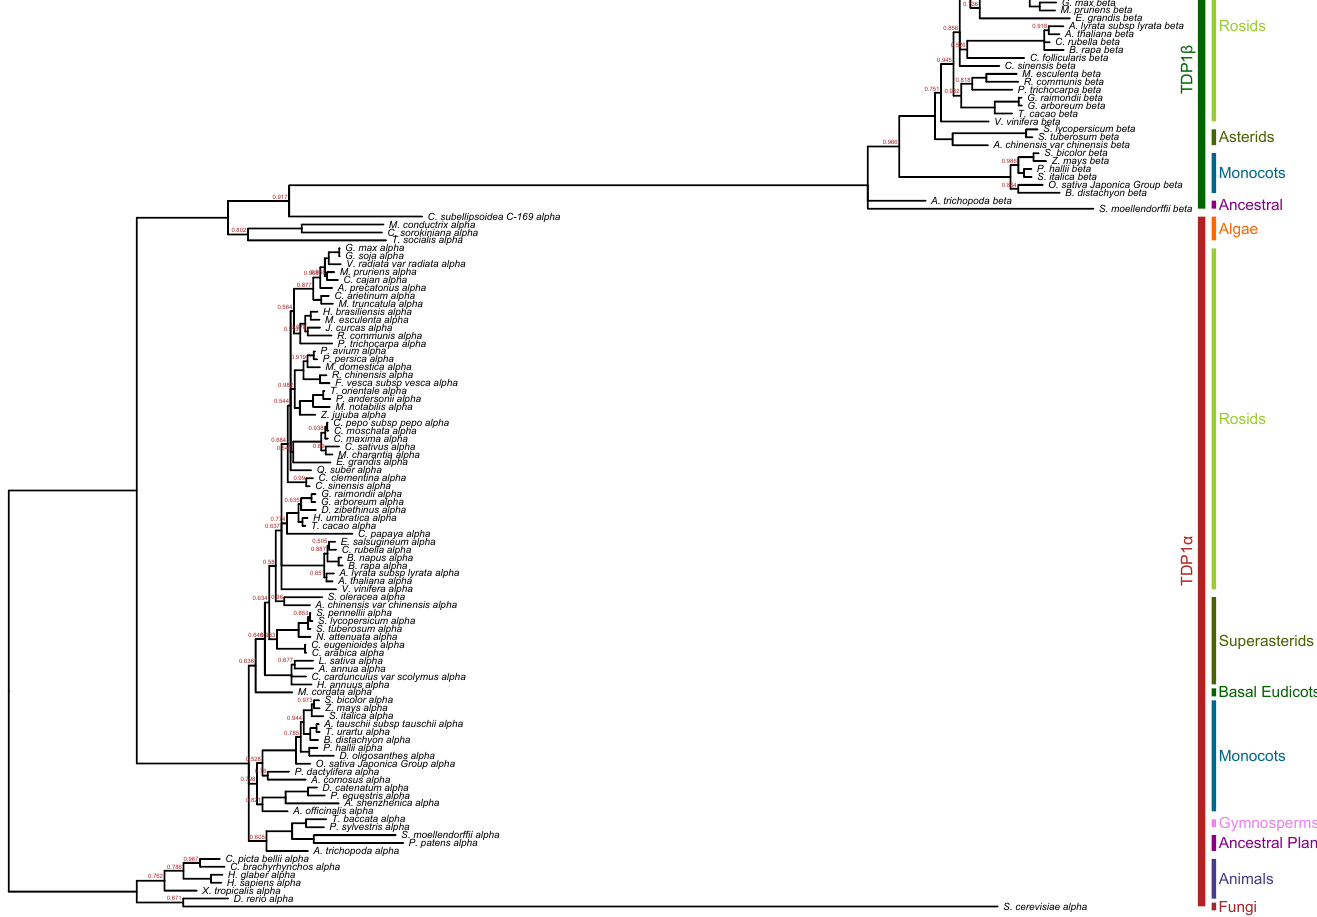
Figure 2. Bayesian phylogenetic tree of combined TDP1 α and TDP1 β protein sequences. The tree is rooted for animals and S. cerevisiae TDP1 α sequences. Posterior probabilities (p.p.) are shown only if < 1. The di ff erent sequences and clades are annotated with di ff erent bar